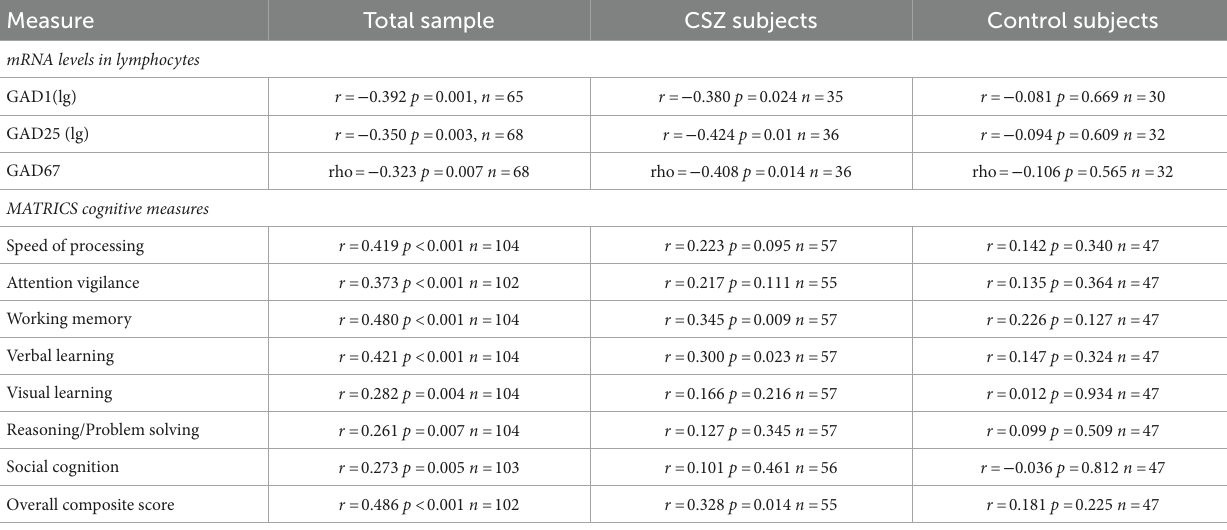
TABLE 5 Correlations between odor discrimination scores and mRNA and cognitive